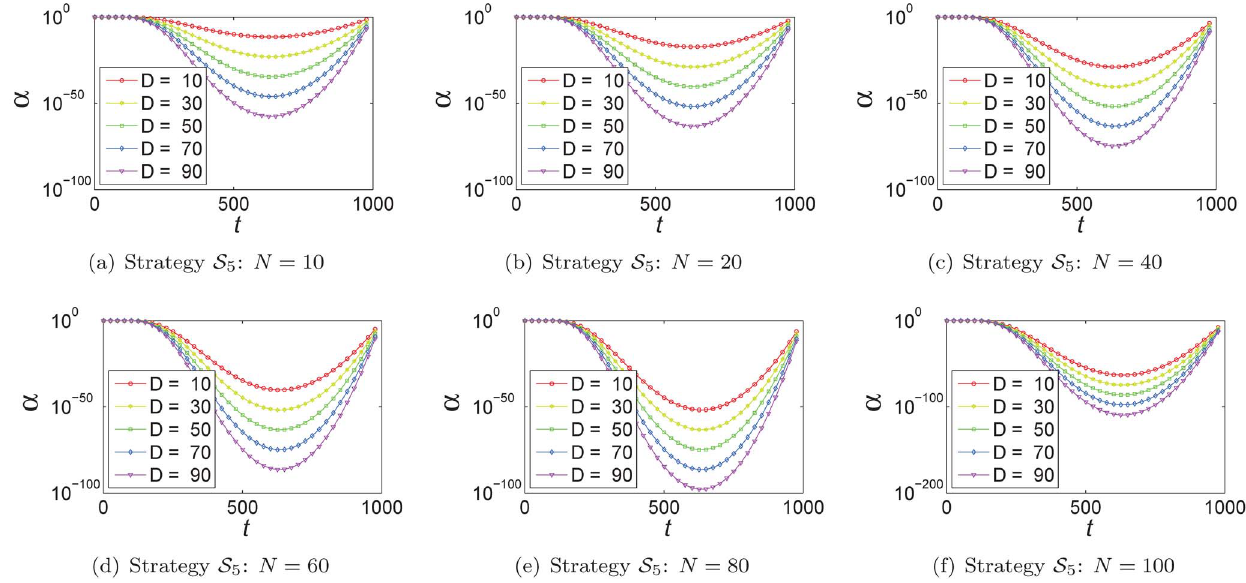
Figure 6. In strategy S 5 , the relationship between a and the size of problem D with different population size N .